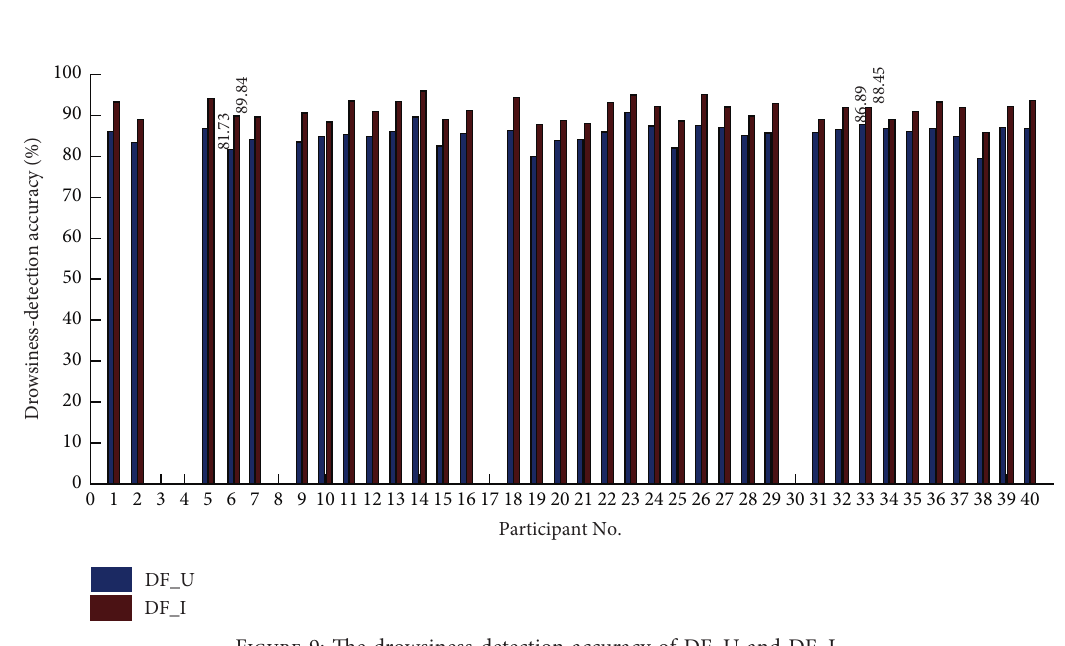
Figure 9: The drowsiness-detection accuracy of DF_U and